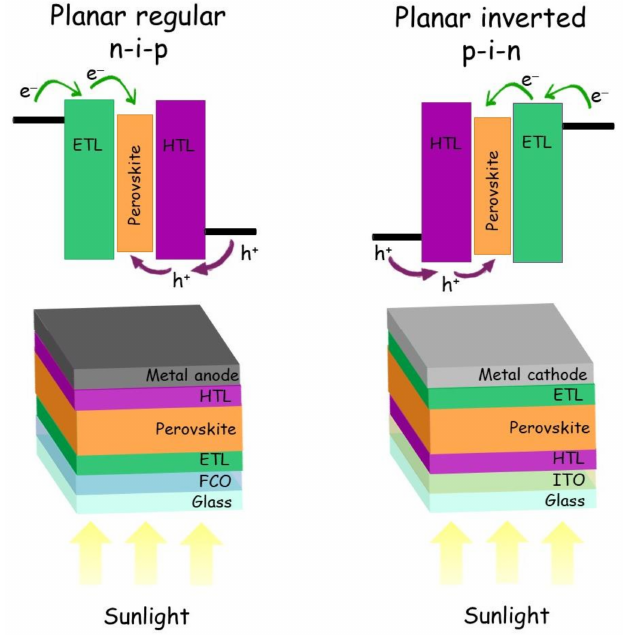
Figure 5. Schematic of perovskite solar cells in planar regular (n-i-p), and planar inverted (p-i-n) architectures.